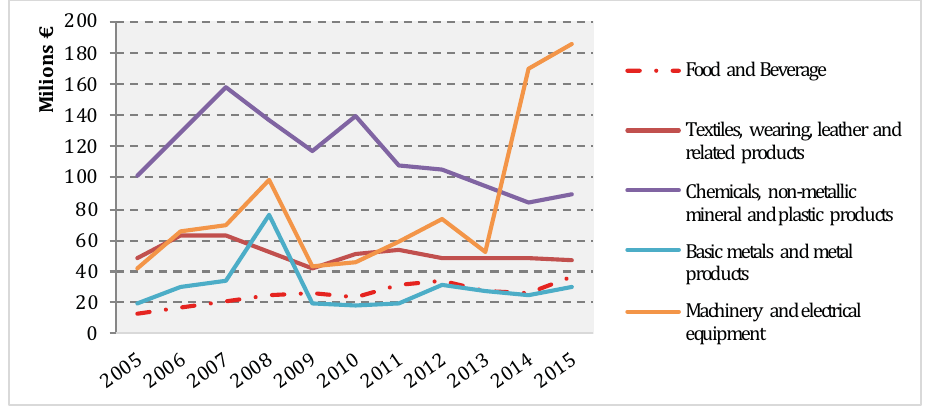
Figure 1. Trend of export of the main sectors of Basilicata’s manufacturing industry 1